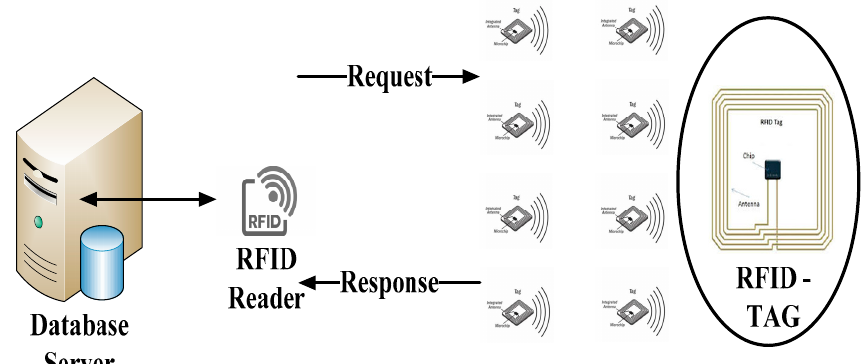
Figure 1. A basic system model of radio frequency identification (RFID).